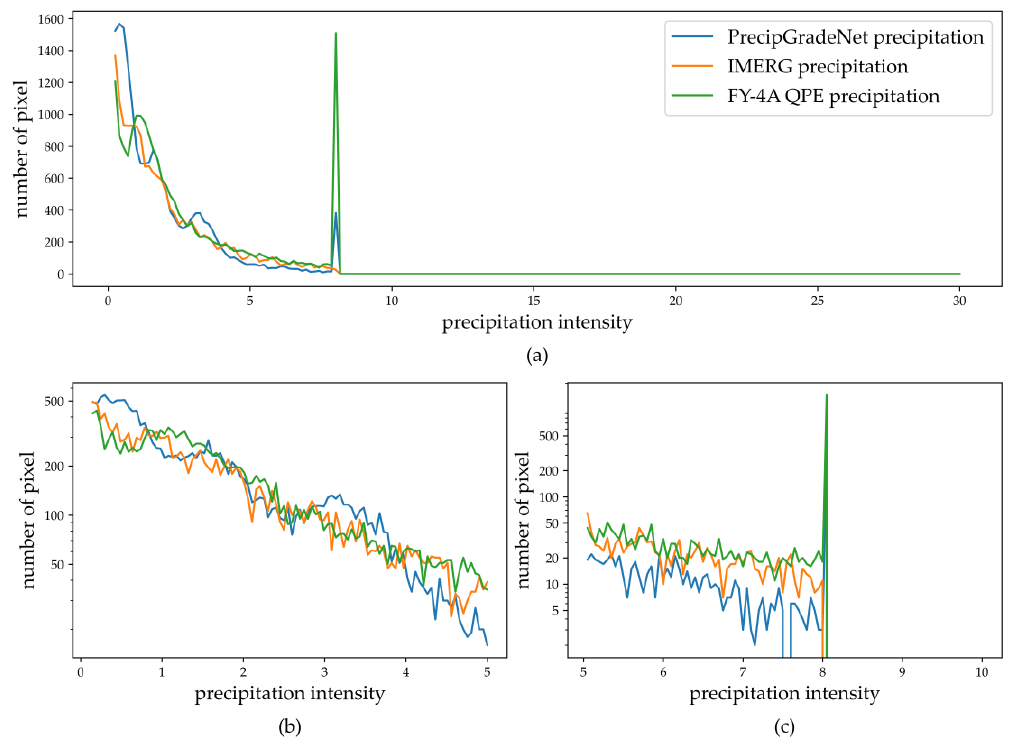
Figure 9. Line graph of precipitation intensity frequency distribution of 3 kinds of QPE in low precipitation dataset by different scales during the test period (from 4 August 2021 to 7 October 2021). ( a ) Line graph of precipitation all between 0 – 30 mm/h. ( b ) Line graph of precipitation between 1 – 5 mm/h. ( c ) Line graph of precipitation between 5 – 10 mm/h.